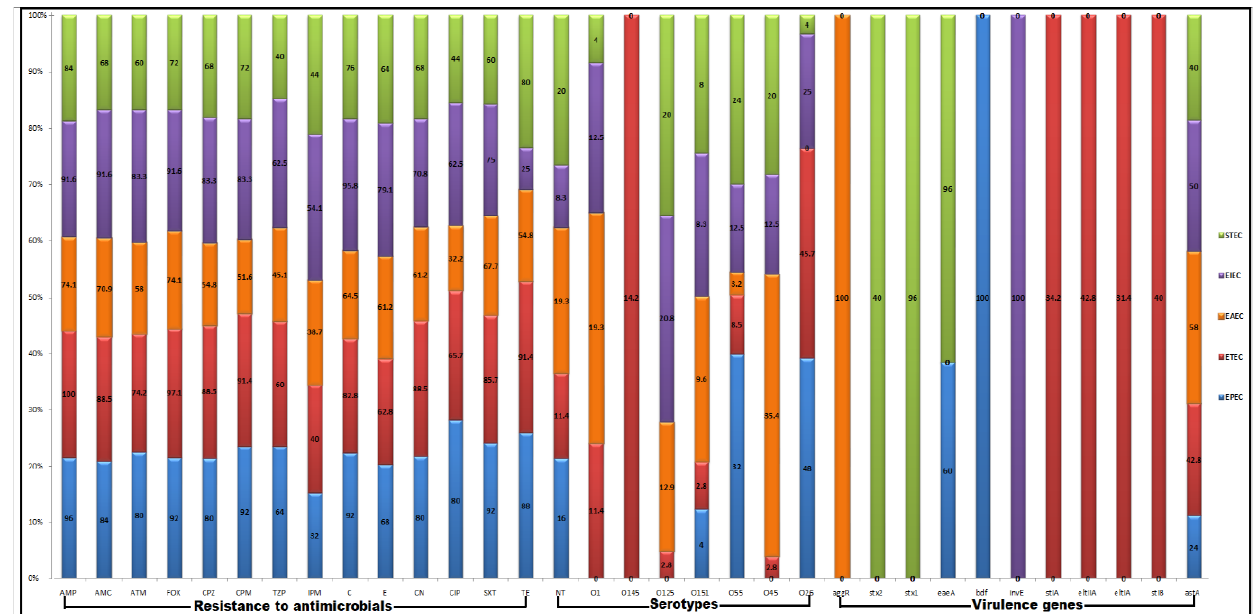
Figure 2. Frequency of resistance to antimicrobials, serotypes, and virulence markers of DEC patho-